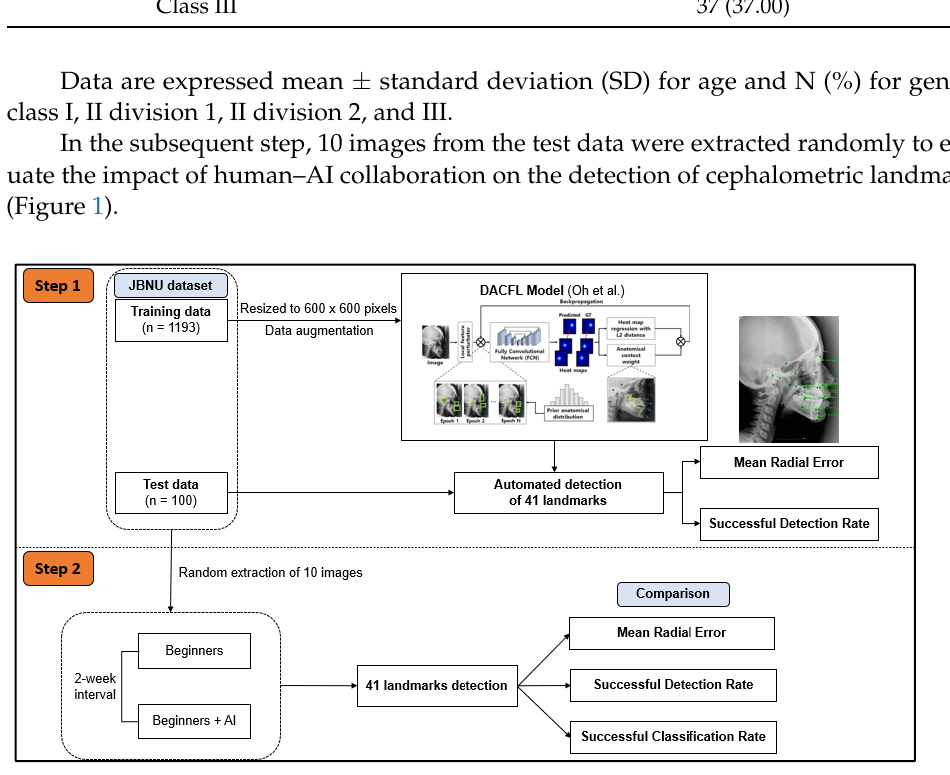
Figure 1. Workflow diagram of the study plan. In step 1, JBNU dataset including 1193 images